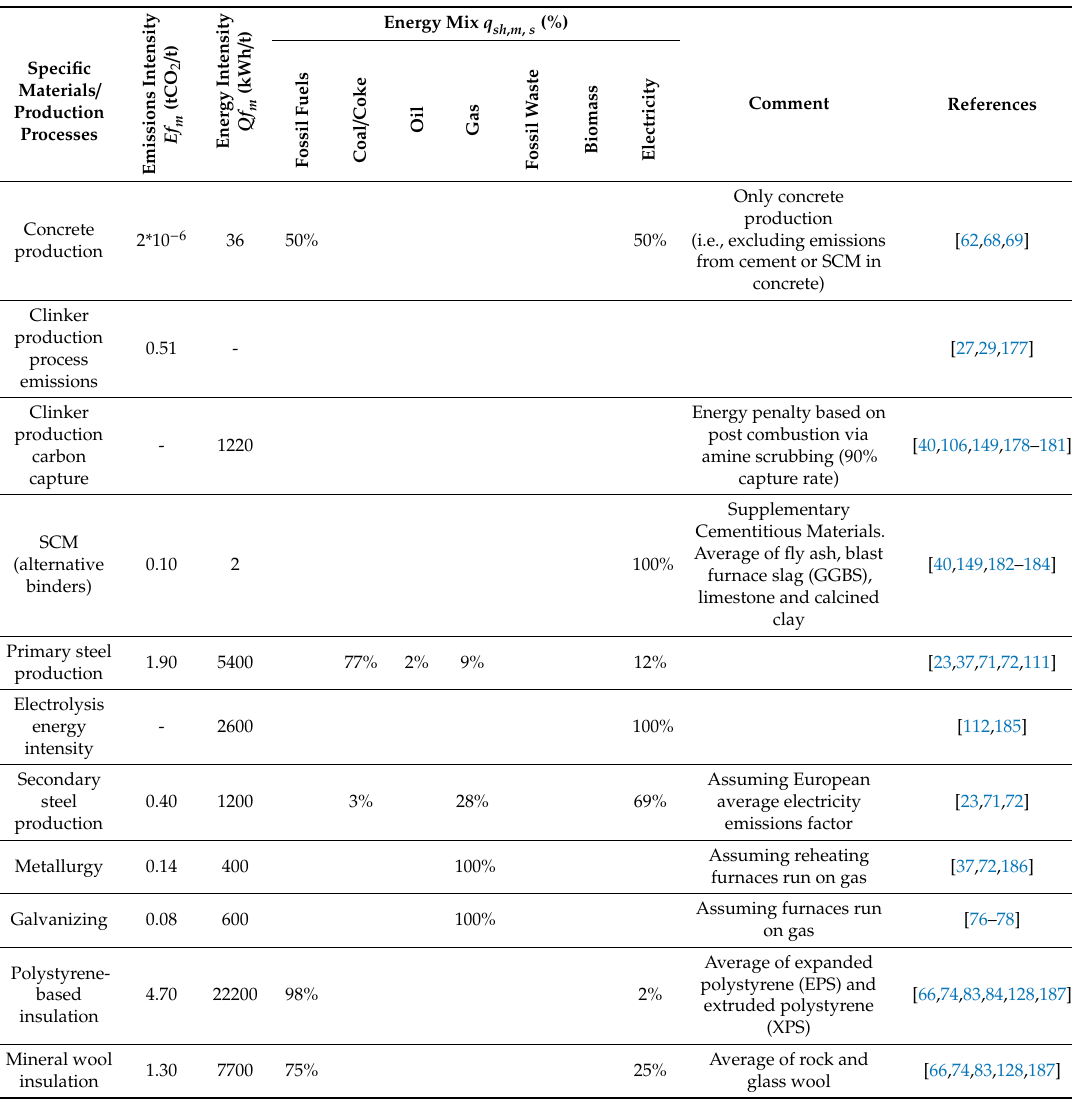
Table A1. Emissions and energy intensity factors along with energy mix for specific materials or material production